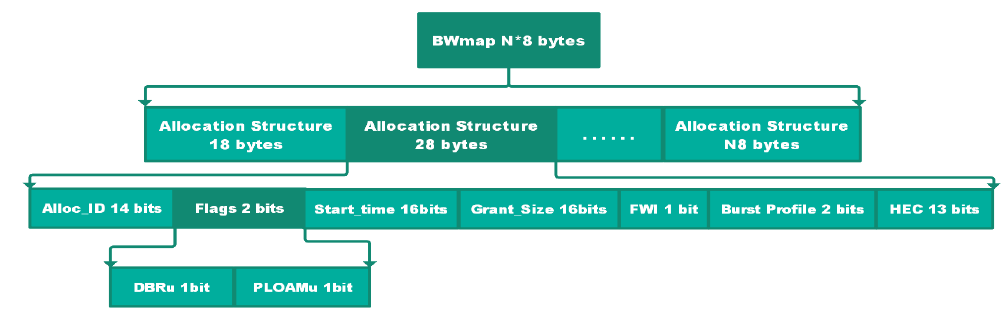
Figure 2. XG-PON downstream (DS) BW map for US data transfer [17].